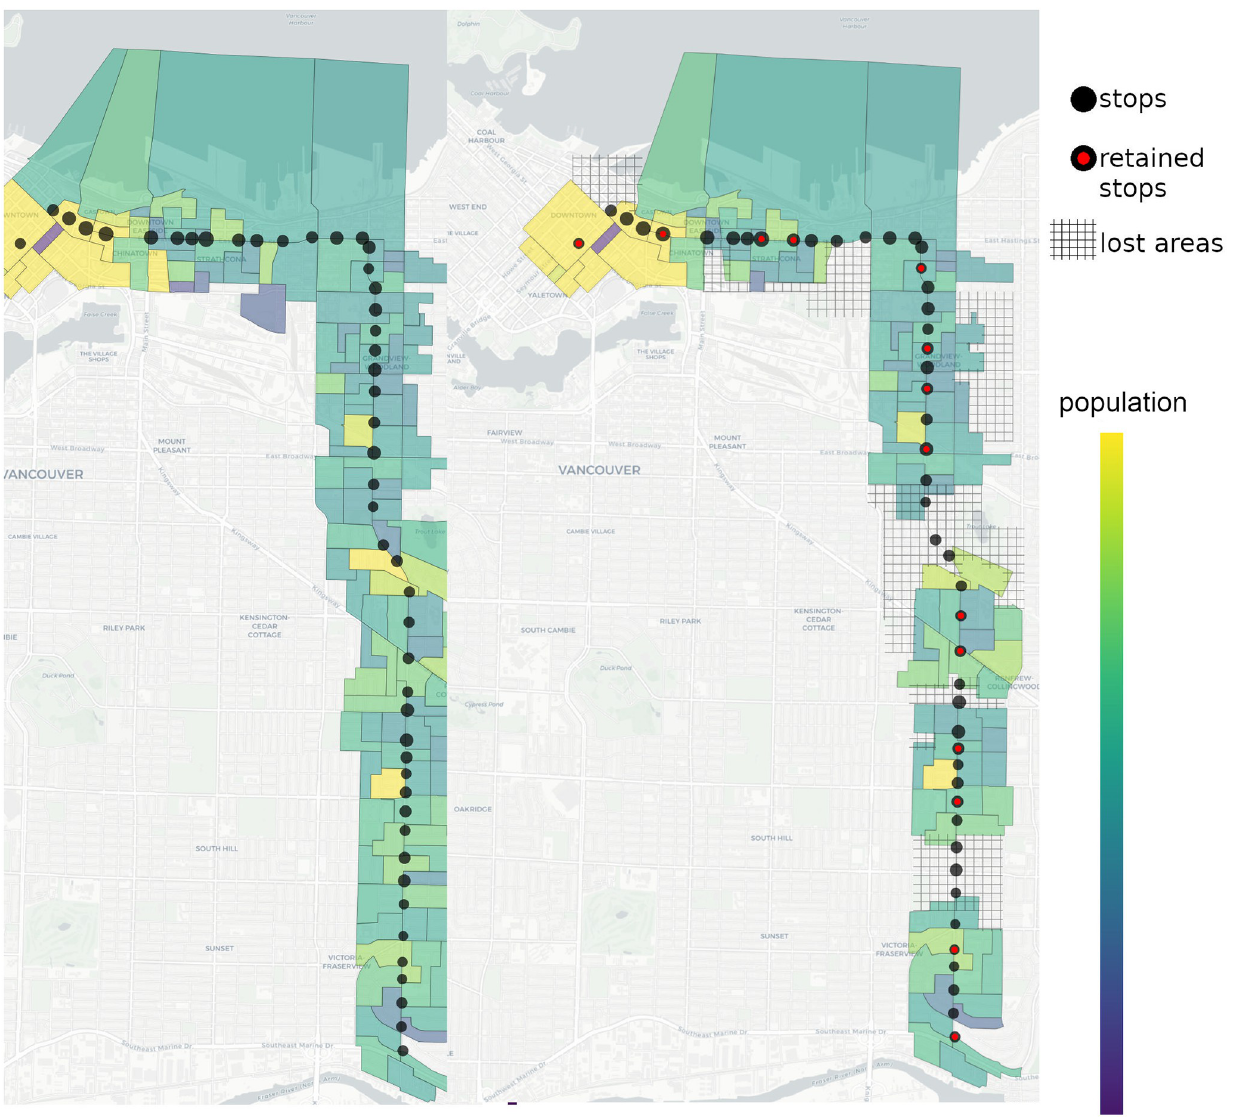
Fig 8. Unoptimized route (Left). Optimized route (Right). The best solution for p = 14 does not cover all the dissemination areas, resulting in an accessibility decrease.